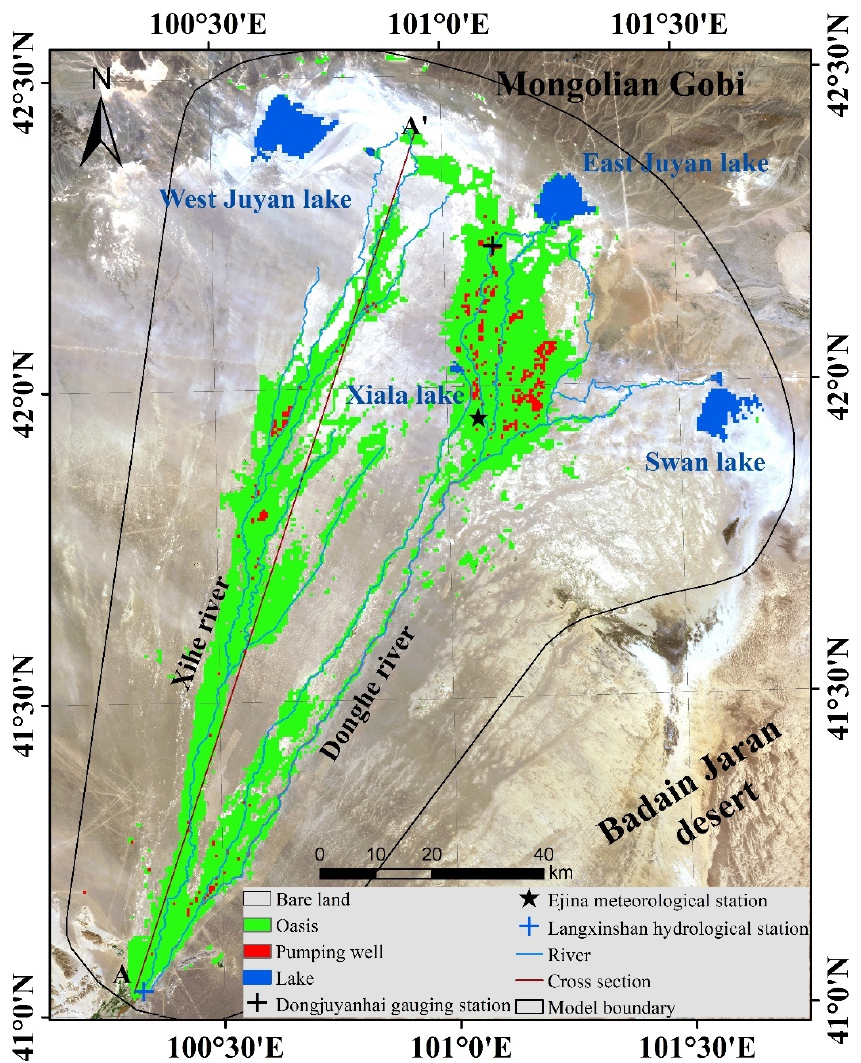
Figure 1. Study site location: the lower reaches of the Heihe River.